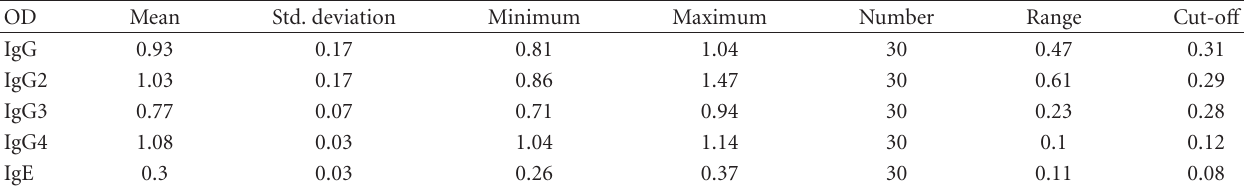
Table 5: The mean OD values of IgG class and subclass responses of 30 naturally infected hyadid patients against B antigen. OD